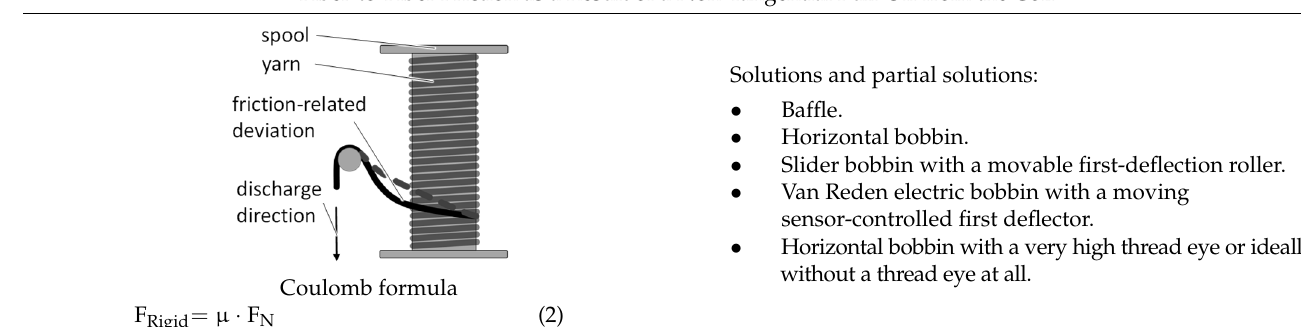
Table 1. Influences on fiber stress and derived solutions.